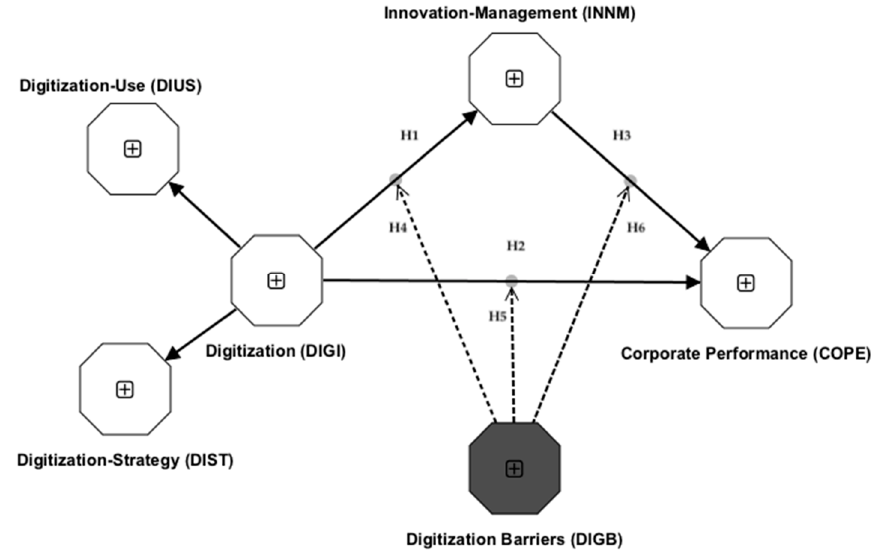
Figure 1. Nomogram of this